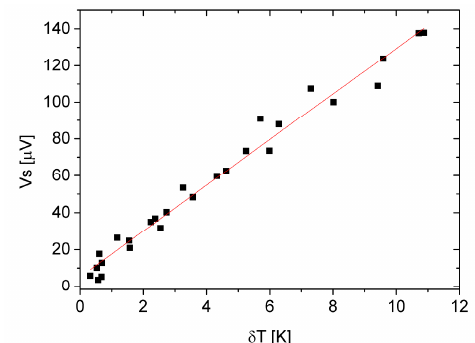
Figure 3. Bi 2 Te 3 nanowire thermovoltage and Seebeck coefficient measurement data, obtained at a base temperature of T = 285